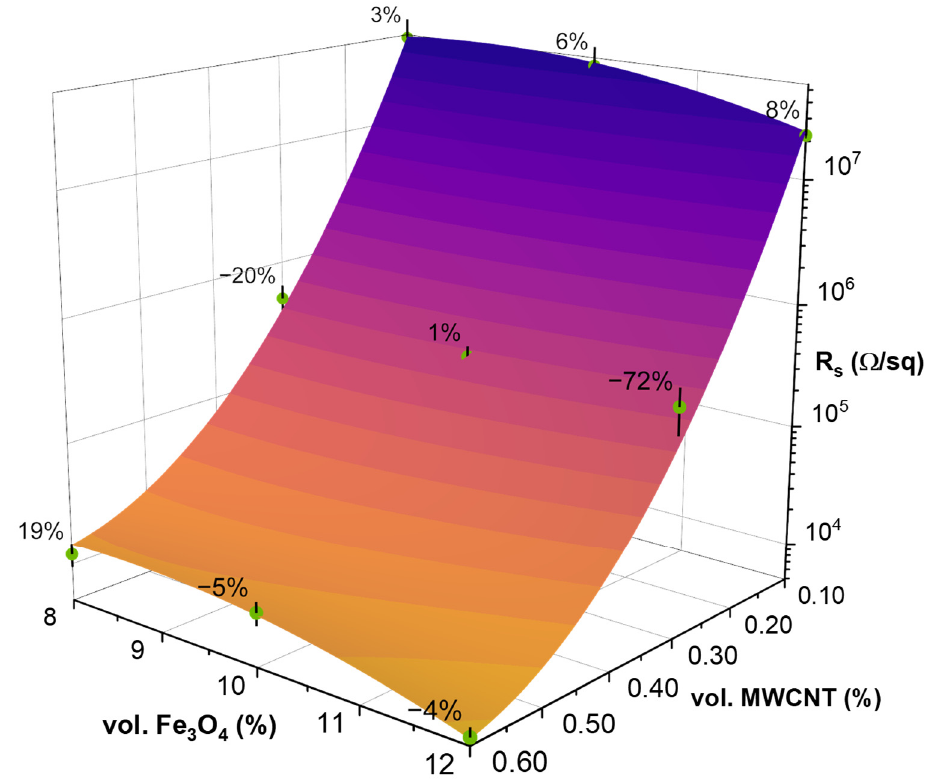
Figure 4. Experimental average surface resistivity values (in green) with error bars (in black), and modelled surface plot for PBS hybrid nanocomposites, with percentage values signifying the deviation of the model from the experimental data.